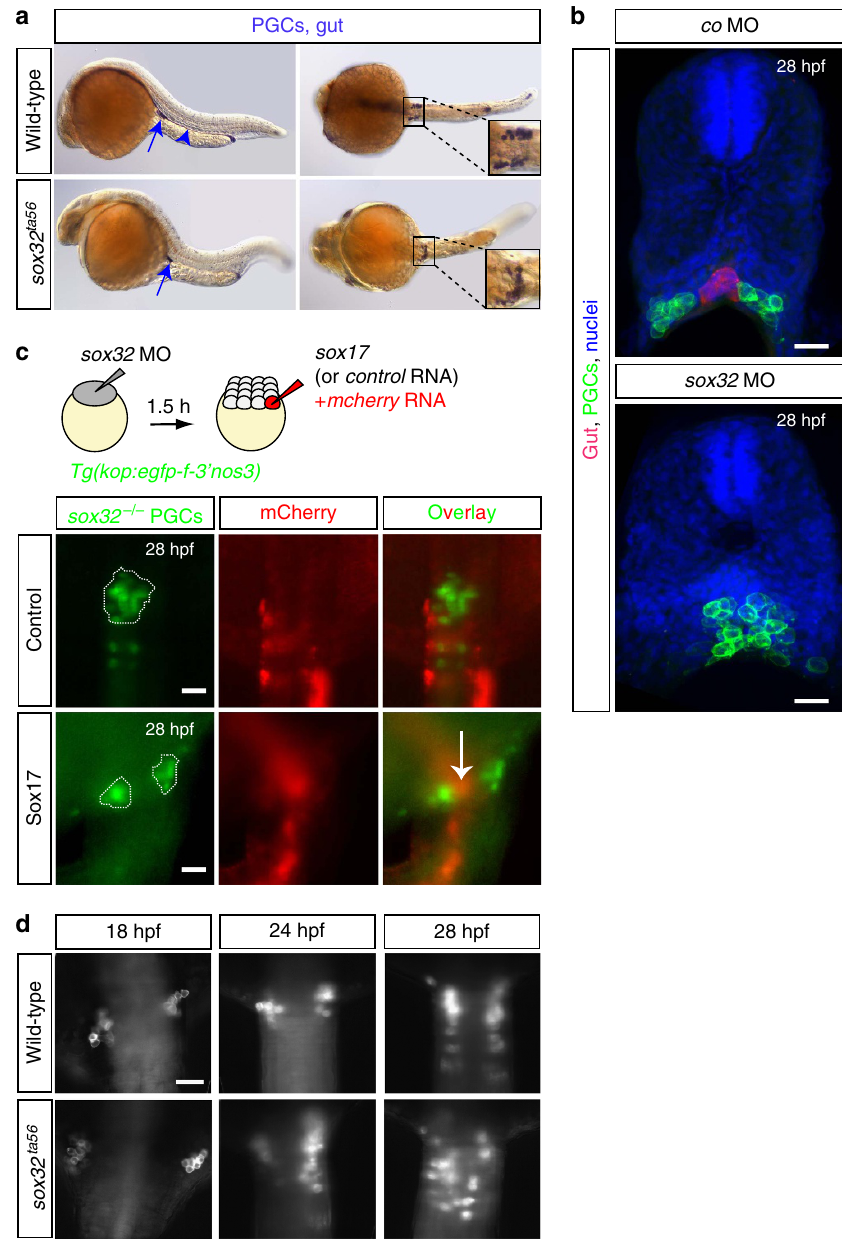
Figure 5 | Lack of the developing gut causes PGC cluster fusion. ( a ) Whole-mount in situ hybridization on 30hpf wild-type ( N ¼ 420) and sox32 mutant embryos ( N ¼ 89). PGCs are labelled with nanos3 ( nos3 , arrows) and the gut with foxa3 probe (arrowhead, missing in sox32 mutant embryos), both in blue. Unlike the separated PGC clusters in wild-type embryos, clusters are fused at the midline in sox32 mutant embryos (upper and lower panel images, respectively). Lateral (left panels) and dorsal (right panels) views are shown. ( b ) Cross-sections of 28hpf sox17:dsred transgenic embryos whose gut is labelled in red and the PGCs membrane with EGFP. In control embryos (upper panel; N ¼ 5) bilateral PGC clusters form on either side of the gut tube. In embryos lacking the gut (Sox32-deficient; N ¼ 4) the PGC clusters fuse (lower panel). Nuclei counterstained with Hoechst. Scale bars, 25 m m. ( c ) Generation of mosaic embryos lacking Sox32 function in all cells whose endoderm is restored by providing Sox17 function to a group of cells (Scheme). The Sox32-deficient PGC clusters (green) are separated by the gut tissue at 28hpf (red in lower panel, arrow; N ¼ 13), while in control embryos lacking endodermal tissues fused PGC clusters are observed (upper panel; N ¼ 24). Anterior is up. ( d ) PGC clusters in wild-type ( N ¼ 20) and sox32 mutant ( N ¼ 7) embryos lacking the gut tissue at 18, 24 and 28hpf showing the dynamics of the fusion. N is the number of embryos analysed. Scale bar, 50 m m. Anterior is